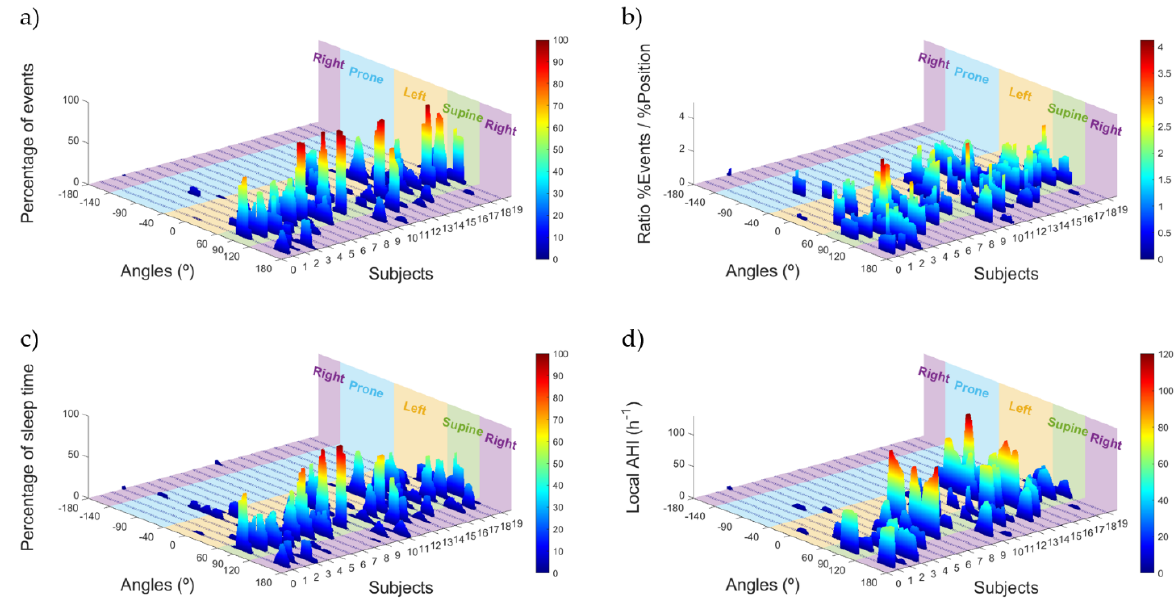
Figure 6. Percentage of OSA events ( a ), the percentage of sleep position time ( c ), the ratio between the percentage of OSA events and the percentage of sleep position time ( b ) and the local AHI ( d ) for each sleep position angle and for each of the subjects of the database. The four discrete sleep position areas have been colored and are shown in the 3D